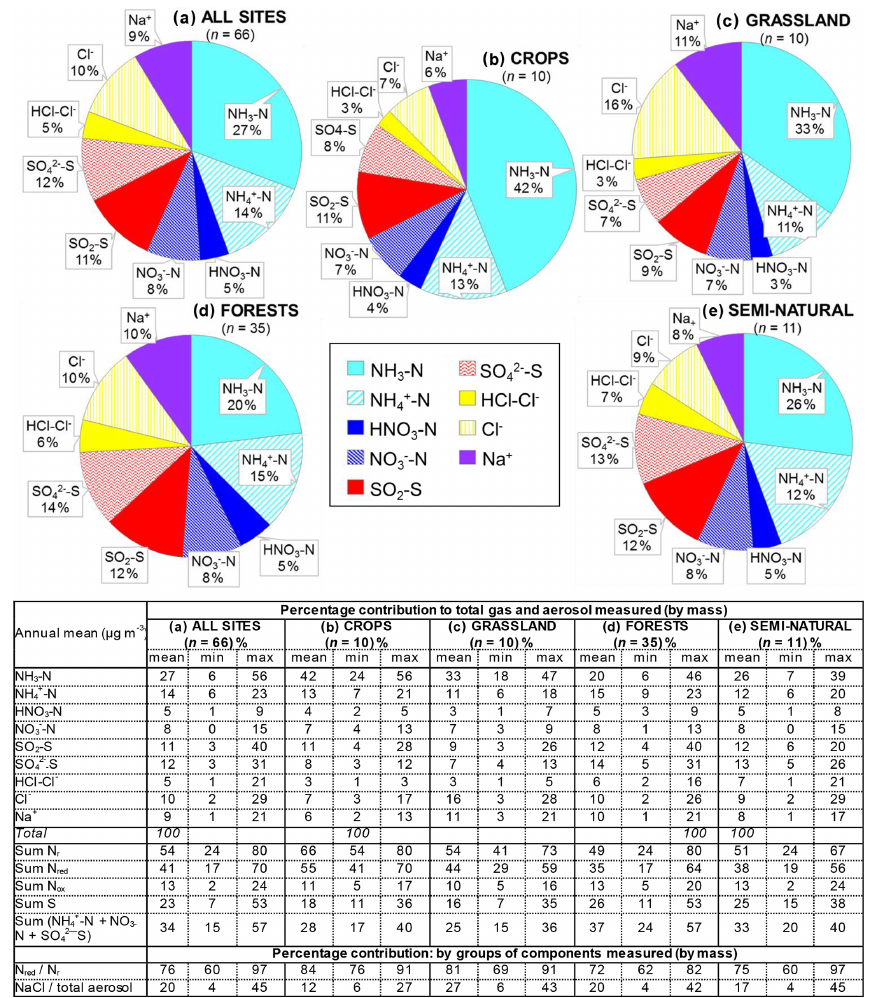
Figure 8. (a, b, c) Pie charts showing the mean atmospheric composition of gas and aerosol components from annual averaged concentrations (µgm − 3 ) measured at NEU DELTA ® sites for (a) all sites ( n = 66) and sites grouped according to ecosystem types, (b) crops ( n = 10), (c) grassland ( n = 10), (d) forests ( n = 35), and (e) semi-natural ( n = 11). UK-AMoP (parallel DELTA ® at Auchencorth: NH 3 and NH + 4 only) and FR-FgsP (parallel DELTA ® at Fougéres: different sample train) were excluded in this analysis. (d, e) Summary statistics on percentage composition by mass (µgm − 3 element) measured. Sum N r = sum (NH 3 –N + NH + –N + HNO 3 –N + NO − –N), sum S = sum 4 3 –S), N red = sum reduced N (NH 3 –N + NH + –N), N ox = sum oxidized N (HNO 3 –N + NO − (SO 2 –S + SO 2 − 4 4 3